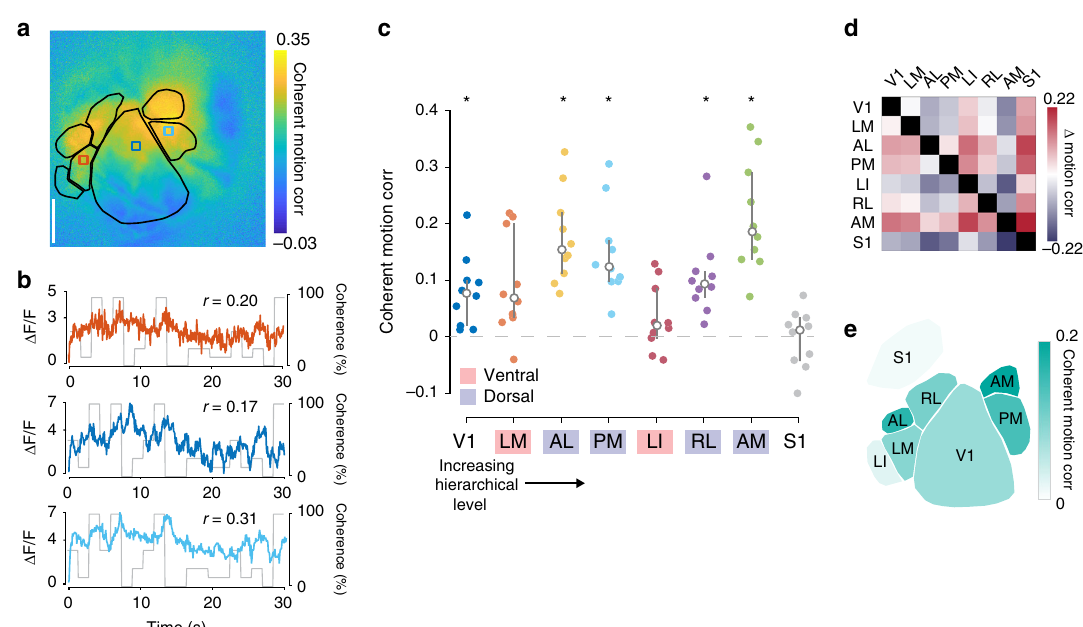
Fig. 3 HVAs exhibit anisotropic coherent motion correlations to RDKs. a Map from a single experiment highlighting anisotropic coherent motion correlations across HVAs. b Single pixel responses taken from area LM (orange; top), V1 (dark blue; middle), and PM (light blue; bottom) overlaid on the coherence trace. Correlation between pixel response and coherent motion trace indicated for each pixel. c Across all mice ( n = 10 sessions over 10 mice), each tested dorsal stream visual area is signi fi cantly motion responsive, but neither ventral stream areas nor a control area outside of visual cortex (region S1) are motion responsive (*Bonferroni adjusted p < 0.006 ( p = 0.05, 8 tests); two-tailed single-sample t test). Overlay indicates median ± quartiles. d Relative difference matrix, with each element equal to the coherent motion correlation in the column region subtracted from the coherent motion correlation in the row region across mice (red, higher; blue, lower). e Simpli fi ed schematic of mean coherent motion correlations in each cortical area across consistently de fi ned HVA (LM, PM, AL, LI, RL, and AM), and somatosensory region S1 (as a negative control).